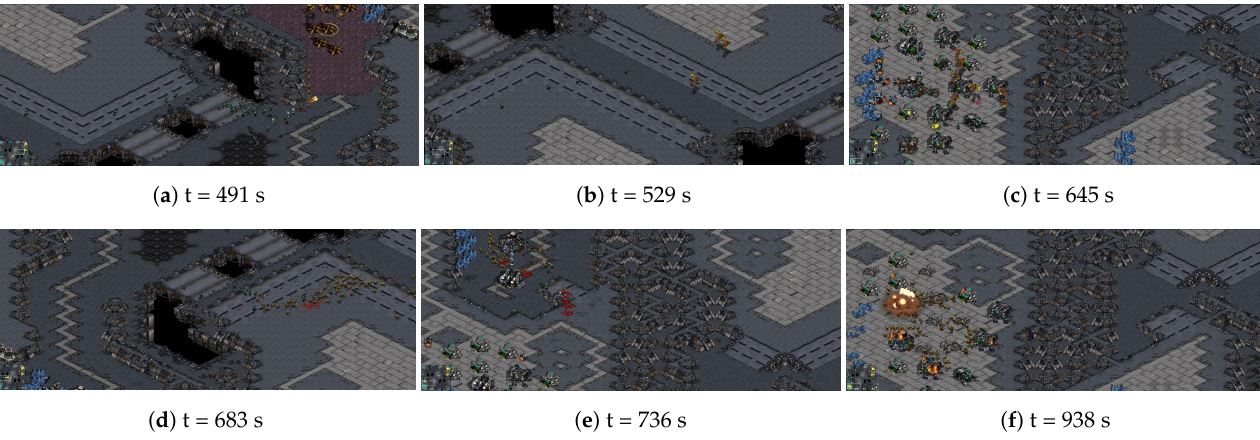
Figure 6. Some snapshots of one match at different times (Best viewed with zoom). ( a ): A few Zerglings of our side and the Marines of the opponent’s side are locked in a face-off. ( b ): The Mutalisks of us attack the opponent’s relief troops. ( c ): The number of our army increases sharply and the Mutalisks’ target is changed to the opponent’s bases. ( d ): The Marines pull back to defeat the opponent’s bases, and they are pursued by massive Zerglings. ( e ): Few opponent’s armies are survived. ( f ): Our army destroys the total opponent’s